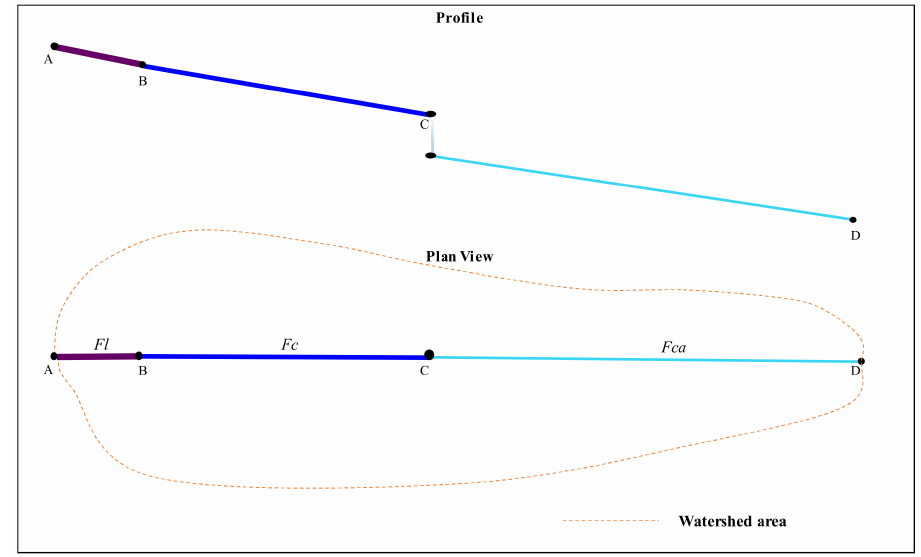
Figure 1. Illustration drawing of the three time of concentration flows of the equation proposed by the